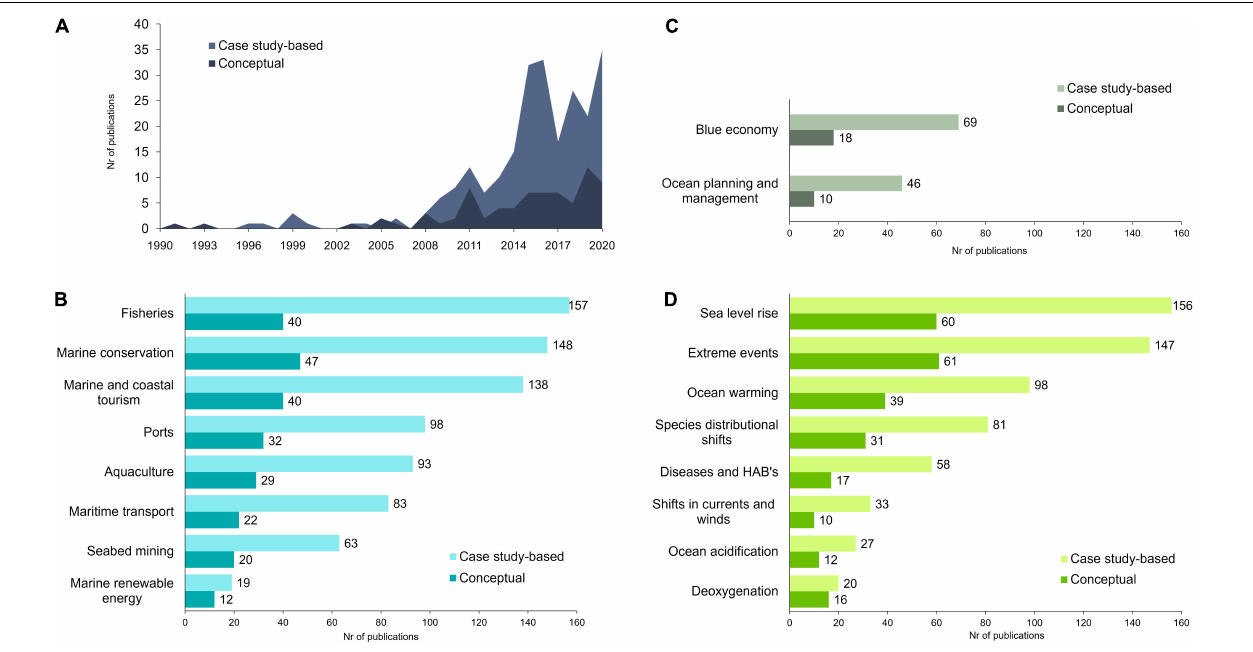
FIGURE 1 | Number of publications included in the analysis according to the year of publication (A) , ocean uses addressed (B) , references to ocean planning and management, or the blue economy (C) , and climate-related drivers of change addressed (D) . Case study-based publications ( n = 237) pertain to those developing a clear assessment for a particular area resulting in specific risk/vulnerability estimates; conceptual publications ( n = 77) pertain to the ones discussing conceptual aspects only. See Supplementary Tables 2 , 3 for details. Nr, number; HABs, harmful algae